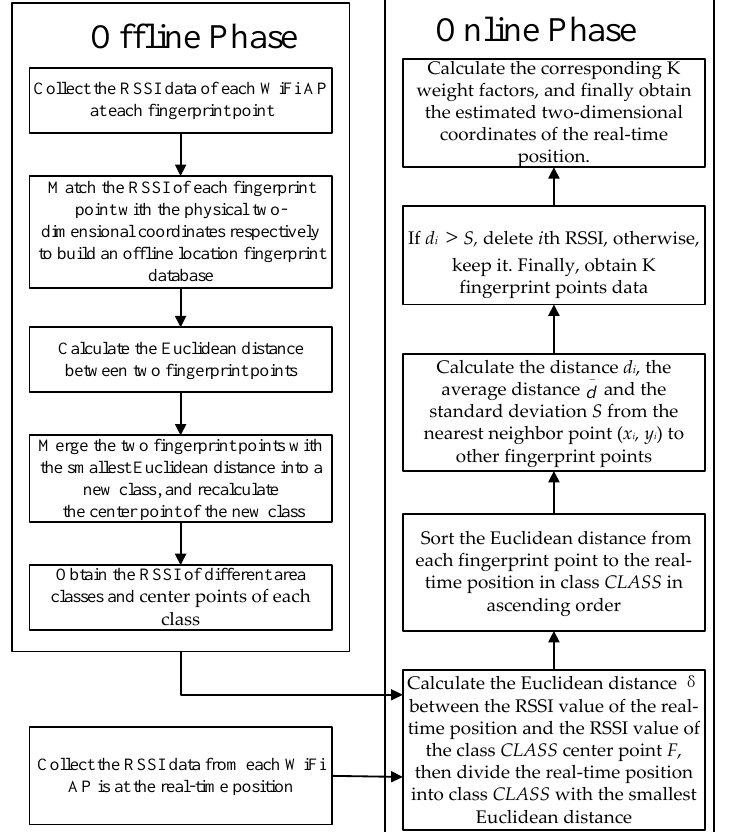
Figure 3. The algorithm steps for the region-adaptive WKNN algorithm based on hierarchical clus- tering.